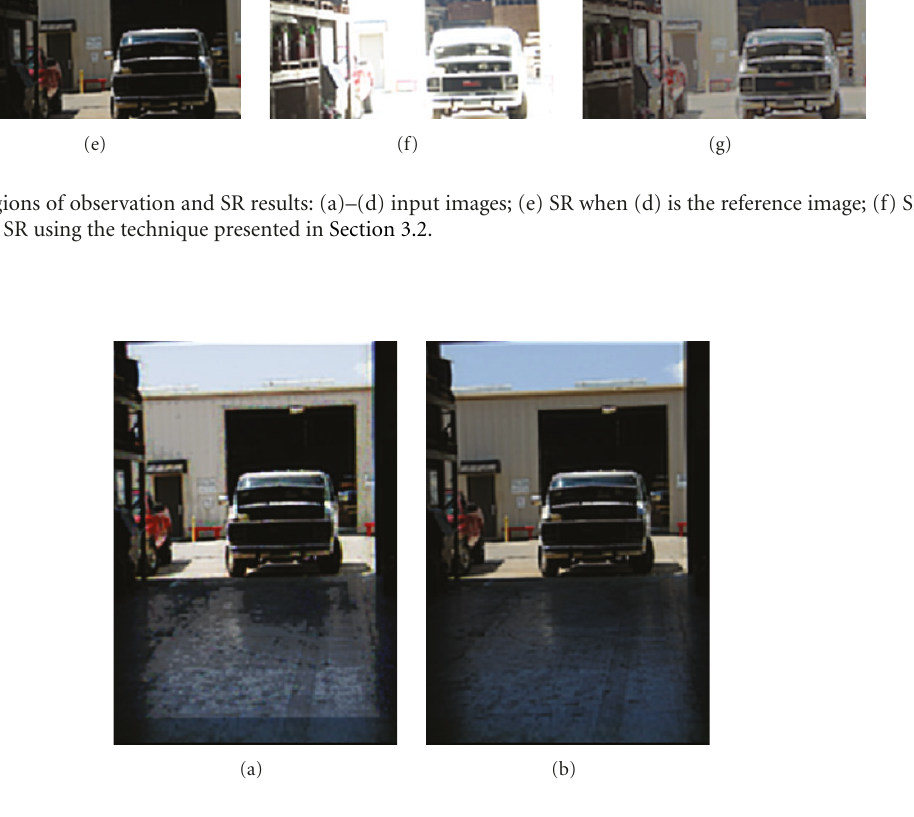
Figure 11: Comparison of weighting function during spatial resolution enhancement. The lowest exposed image is chosen as reference. (a) SR reconstruction using identity weight, (b) SR reconstruction using a hat function as